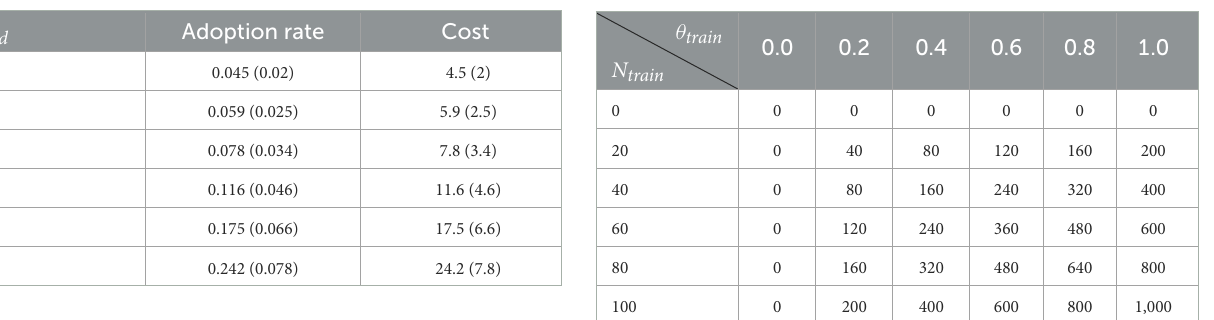
TABLE 5 Adoption rate by level of financial support: mean value for the 50 replications and standard deviation in brackets.